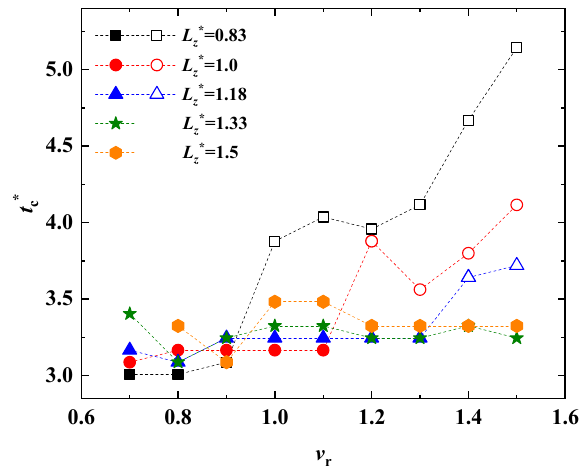
Figure 6. Contact time of two successive droplets with various droplet ratios and L z * .